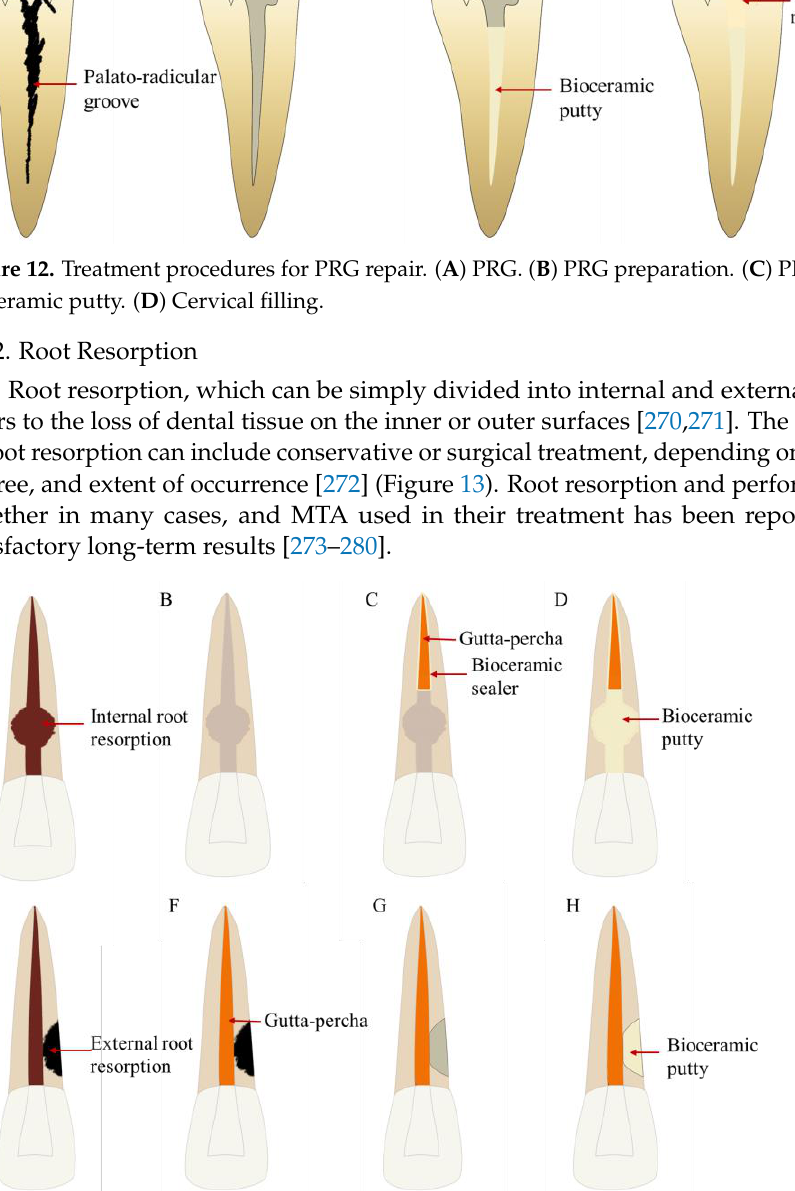
Figure 13. Treatment procedures for root resorption repair. ( A – D ) Treatment procedures for internal root resorption repair. ( A ) Internal root resorption. ( B ) Root canal cleaning. ( C ) Root canal filling in the apical segment with gutta-percha and bioceramic sealer. ( D ) Internal root resorption repaired with bioceramic putty. ( E – H ) Treatment procedures for external root resorption repair. ( E ) External root resorption. ( F ) Root canal therapy. ( G ) External root resorption preparation. ( H ) External root resorption repaired with bioceramic putty.